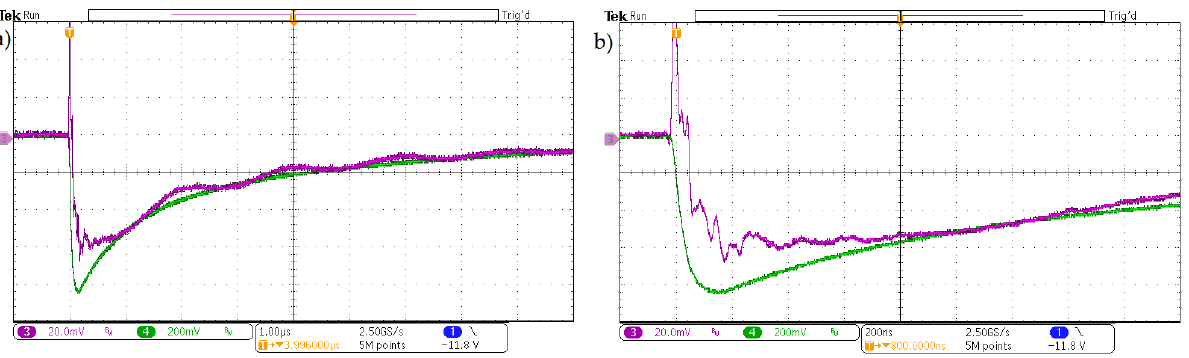
Figure 7. Measured current signal in the function of time—( a ) 1 μs/div; and ( b ) 200 ns/div—CH3: LEM sensor LA55-P, CH4: ALCS—augmented LEM current sensor.